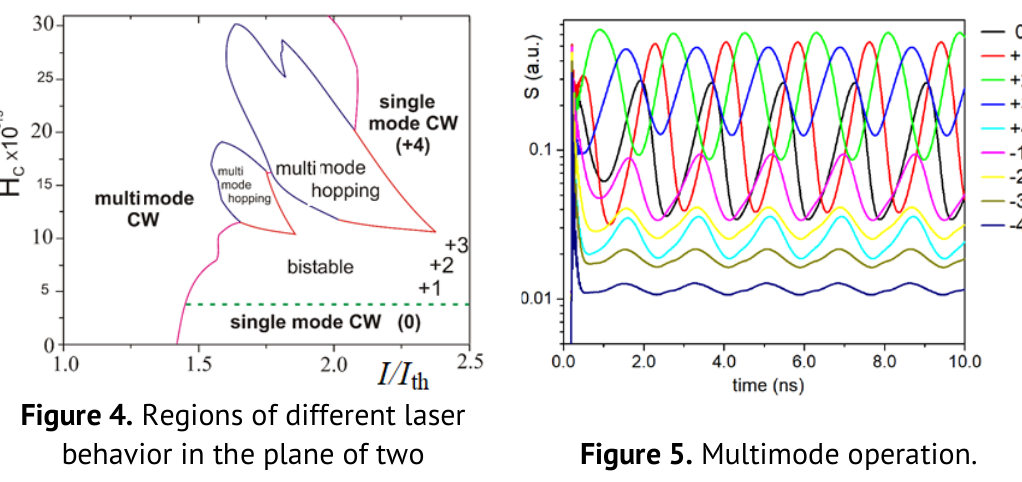
Figure 5. Multimode